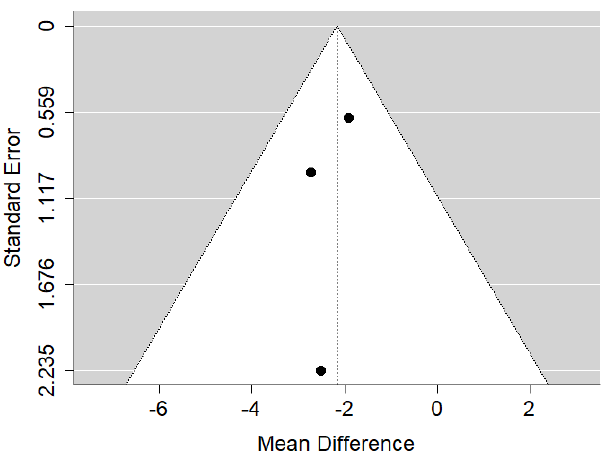
Figure 5. Funnel plot of ANB values for the comparison of patients with untreated submucous cleft